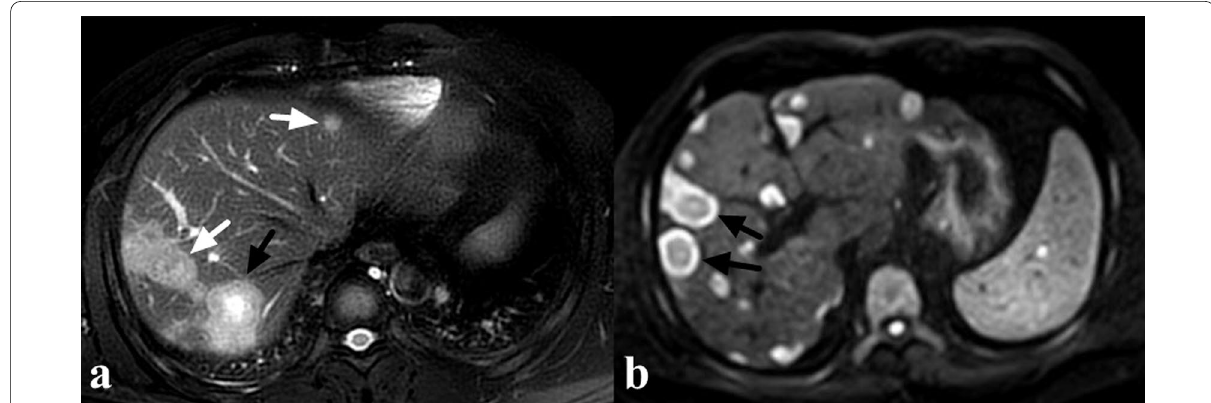
Fig. 4 A 38-year-old male HEH patient. a On fat-saturated T2 weighted image, target sign could be observed on a medium lesion (black arrow), while both small and large lesions failed to show target appearance (white arrow). b Target sign on DWI image (800 b-value), consisted of concentric layers including relatively hyperintense in central tumor regions and peripheral zones which were markedly hyperintense relative to liver parenchyma (arrows)